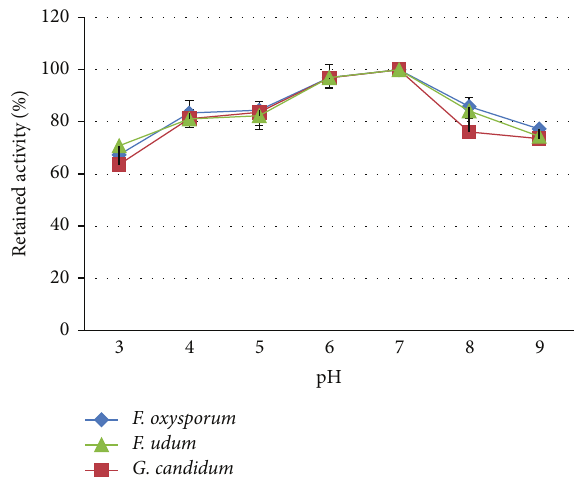
Figure 5: Stability to pH of the antifungal